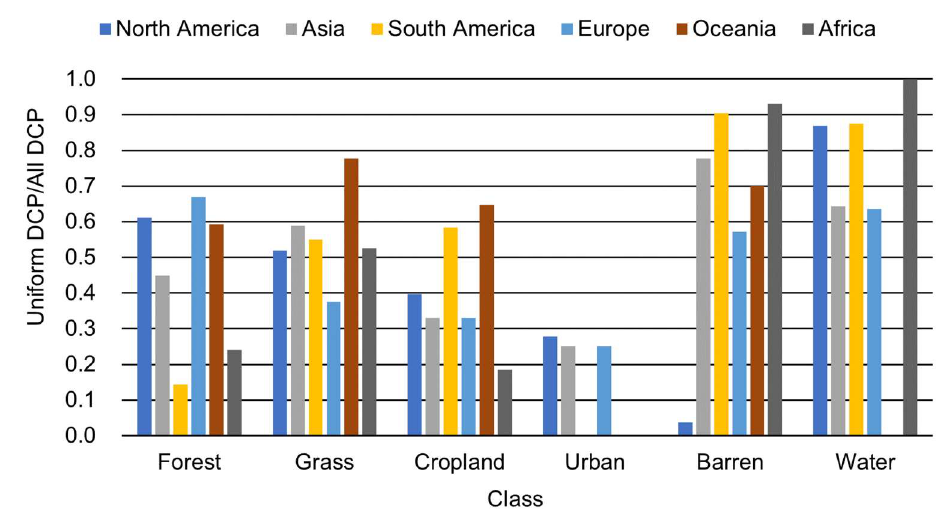
Figure 6. Proportion of DCP points with guaranteed spatial uniformity among all DCP points per continent in the 300 m scale.